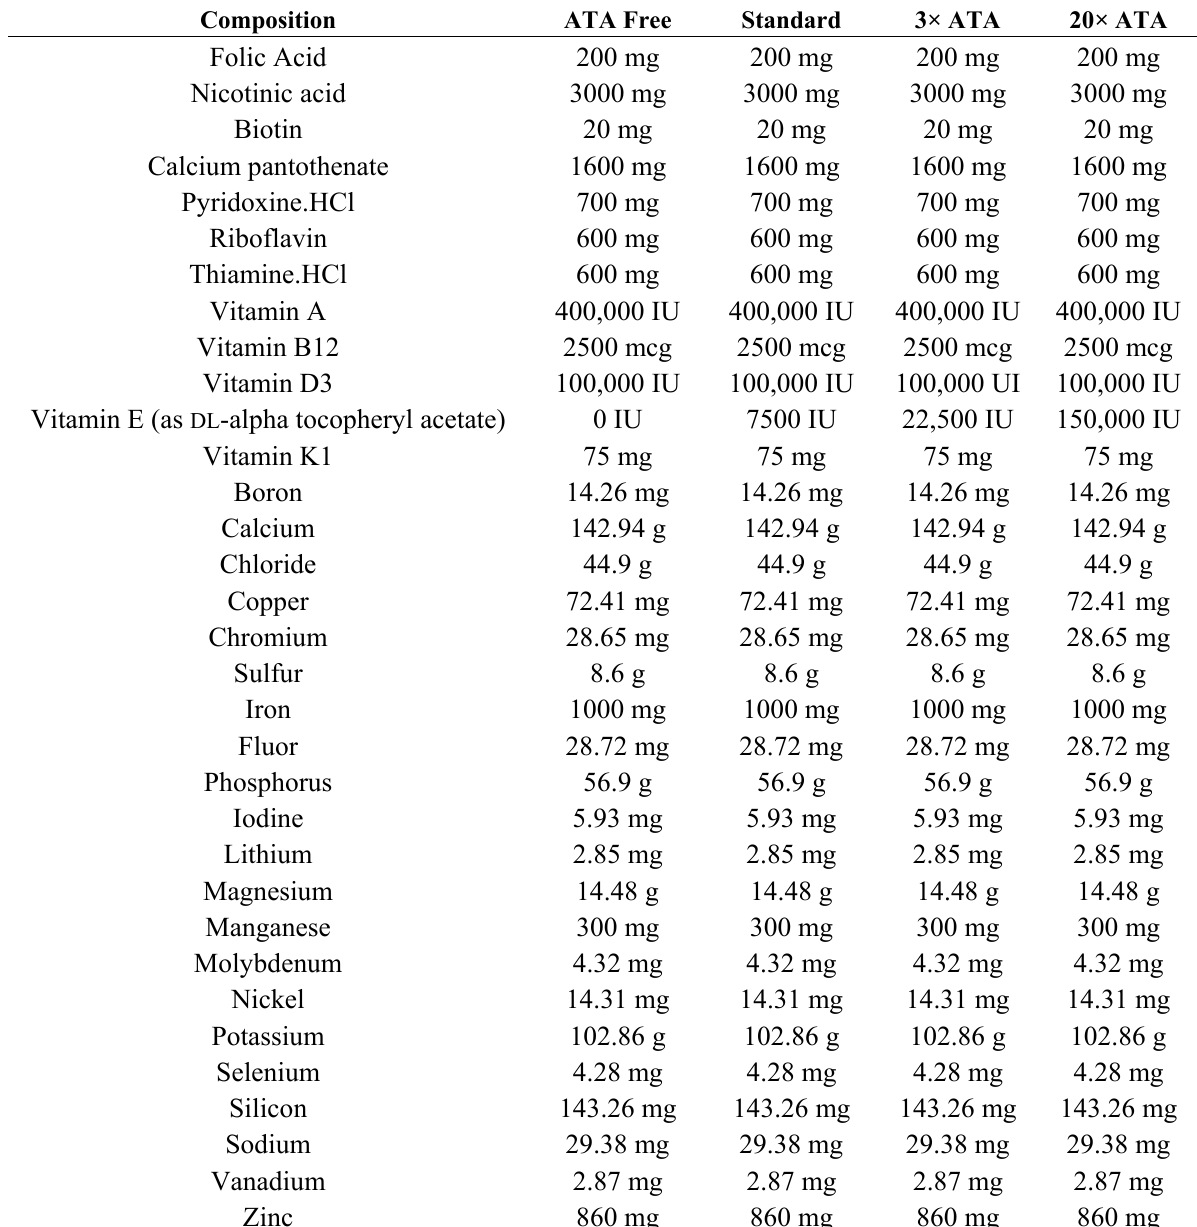
Table 2. Composition of the vitamin and mineral pre-mix AIN-93 (Rhoster)/kg of the